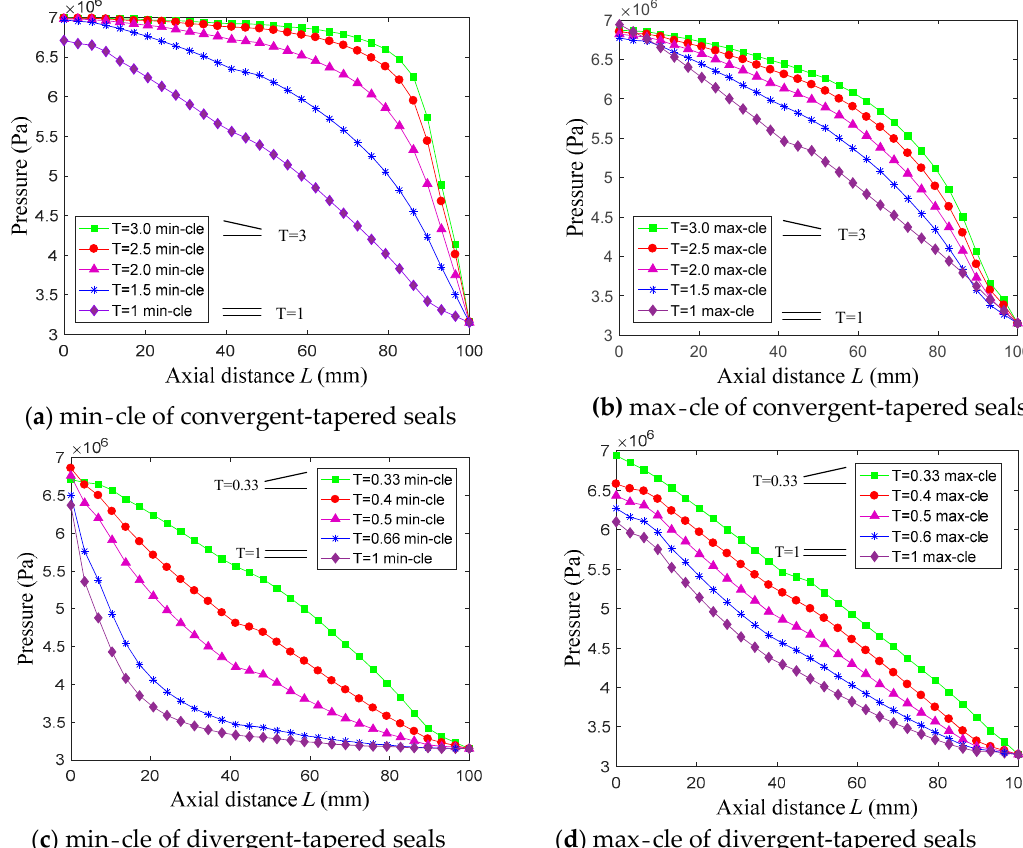
Figure 12. Pressure distribution of the rotor surface. ( a ) min - cle of convergent-tapered seals; (b) max - cle of convergent-tapered seals; ( c ) min - cle of divergent-tapered seals; ( d ) max - cle of divergent-tapered seals.